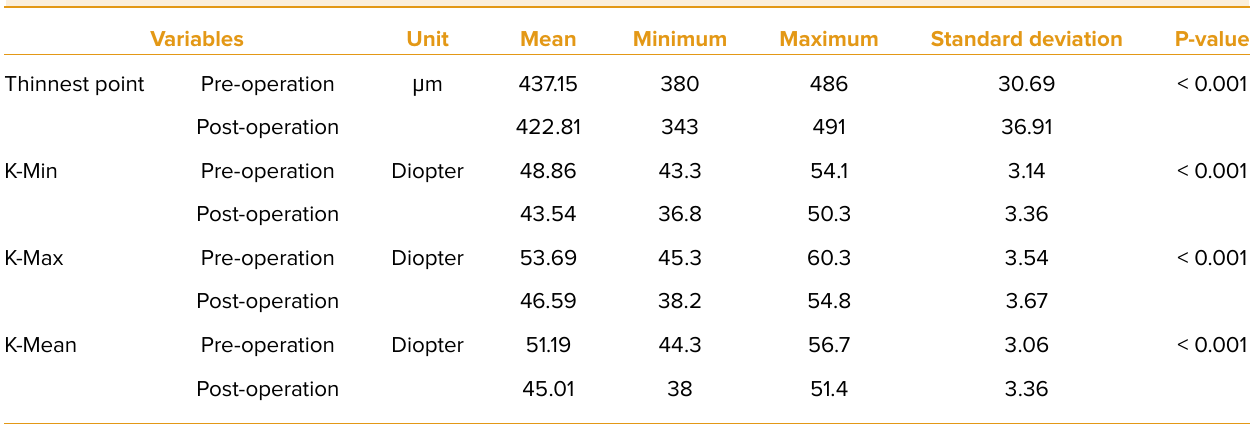
Table 2. Descriptive statistics of the keratometry and the thinnest point of the cornea